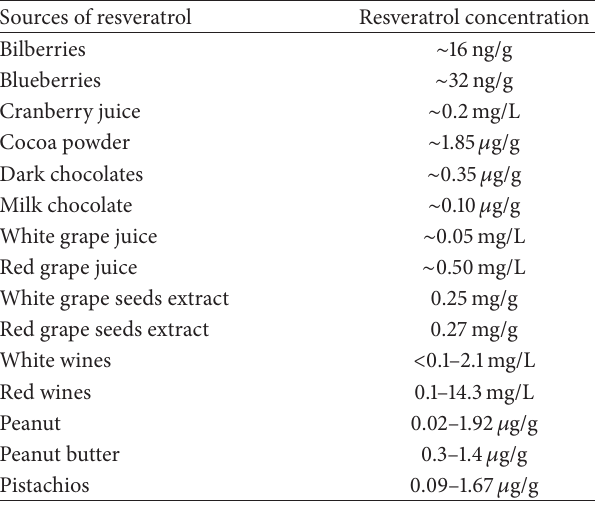
Table 1: Common sources of resveratrol and their estimated